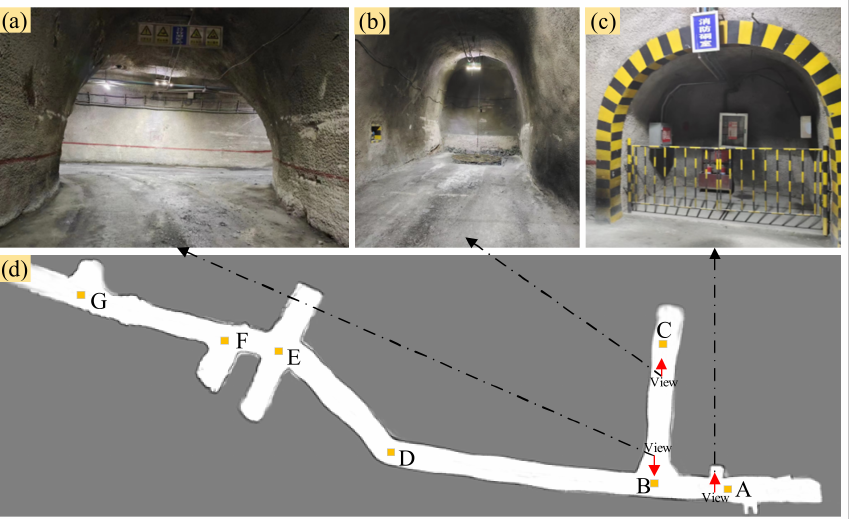
Figure 2. The laneway of Mine A for which dataset 1 was collected. ( a ) The view of the intersection; ( b ) the view of the orepass; ( c ) the view of the firefighting chamber; ( d ) the map. Note: ( a – c ) correspond to the views of the three red arrows in ( d ) respectively. A–G in ( d ) are the sampling points of the